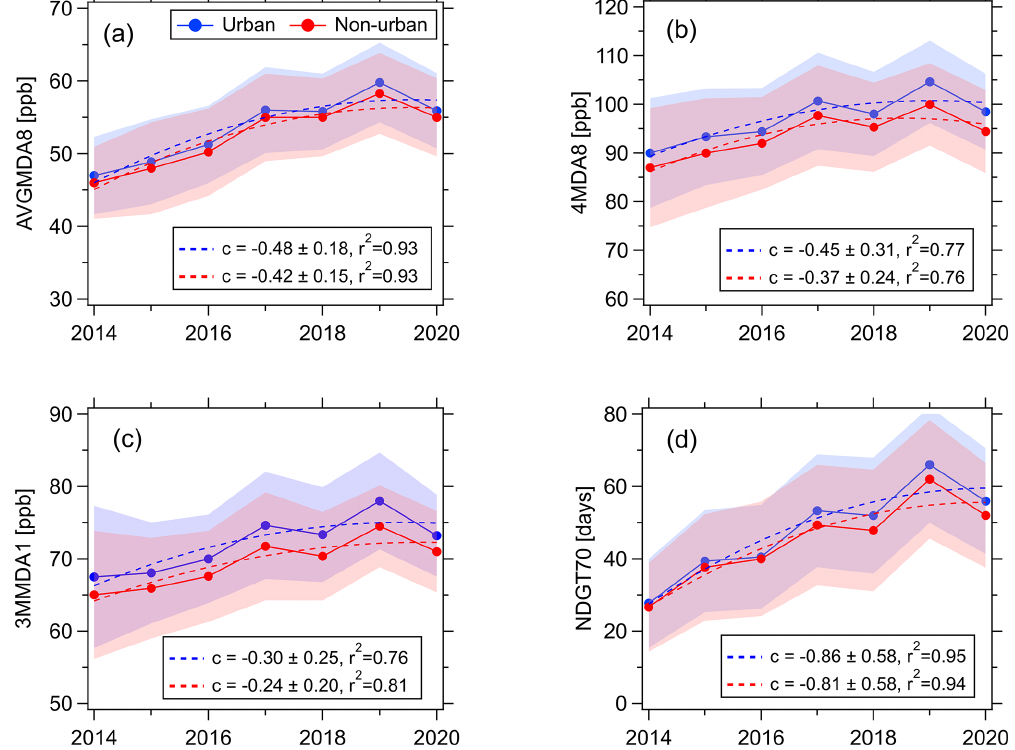
Figure 4. Variations in four O 3 metrics: AVGMDA8 (a) , 4MDA8 (b) , 3MMDA1 (c) and NDGT70 (d) at urban and non-urban sites during 2014–2020. The AVGMDA8 is the mean MDA8 O 3 in the warm season (April–September), and the other metrics are annual values. Shaded areas represent the range of mean values ± the 50% standard deviation (SD) for each metric. The dashed lines are fitted by the polynomial function ( y = a + bx + cx 2 ). The quadratic polynomial coefficient c ( ± 1SD) and the determination coefficient r 2 are given.